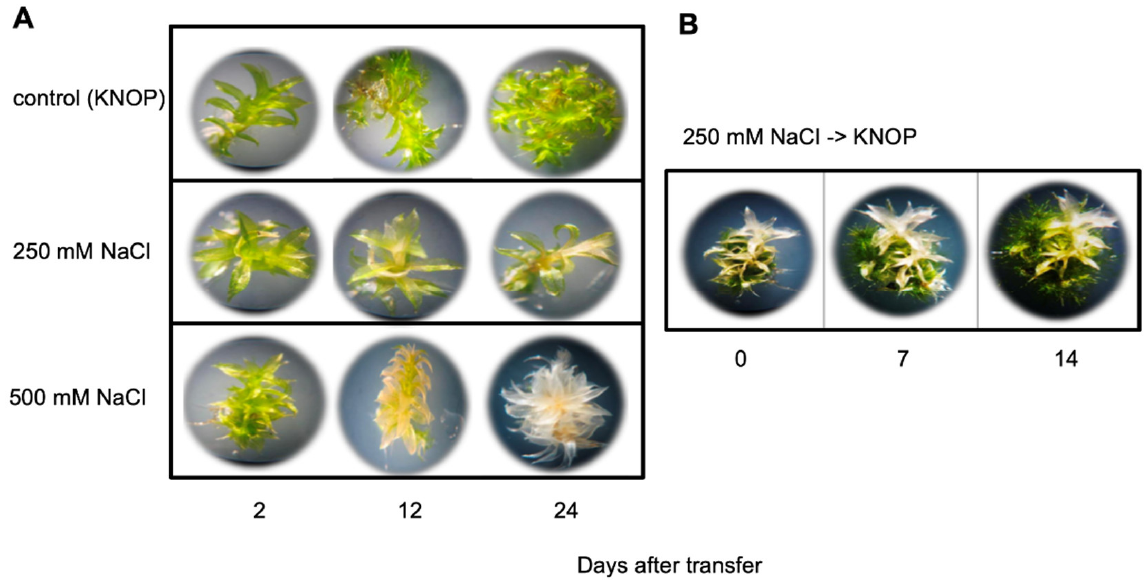
Figure 1. Growth of P. patens gametophores on medium containing high salt concentrations: ( A ) Individual gametophores are shown that have developed for 2, 12, and 24 days on either control medium without salt or on 250 mM and 500 mM NaCl; ( B ) Individual gametophores were transferred after 3 weeks from 250 mM NaCl to medium without salt and were photographed 7 and 14 days after transfer. In panel ( B ), at each time point the same plant was photographed.